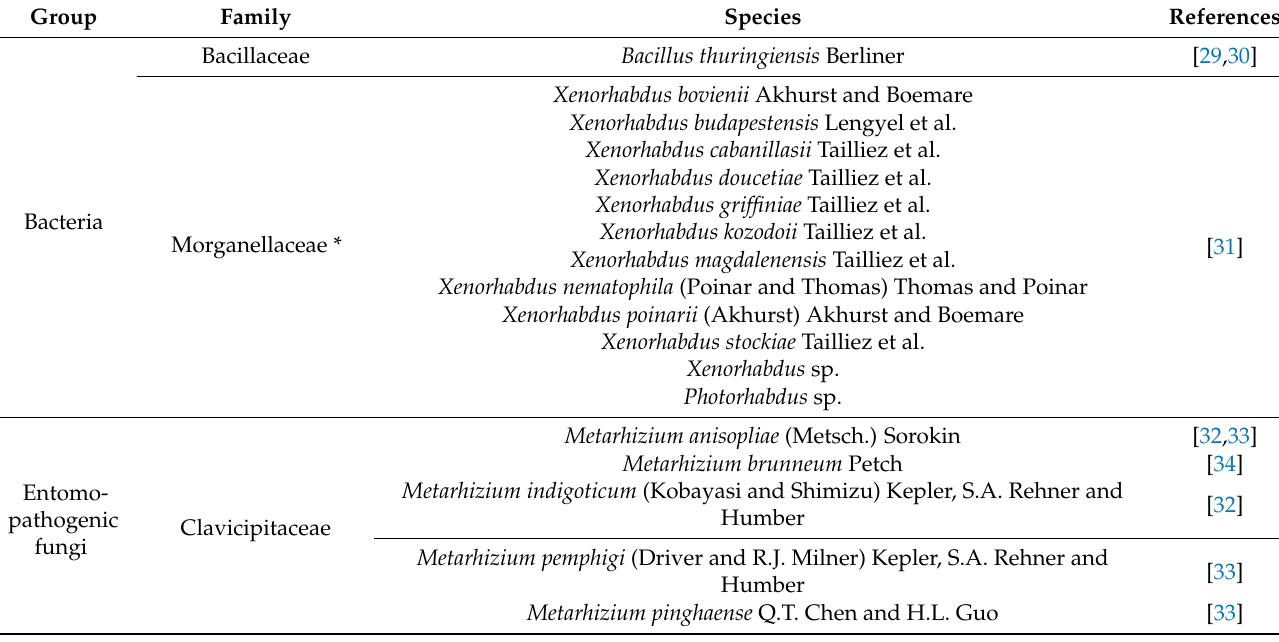
Table 1. List of biocontrol agents tested for control of bulb